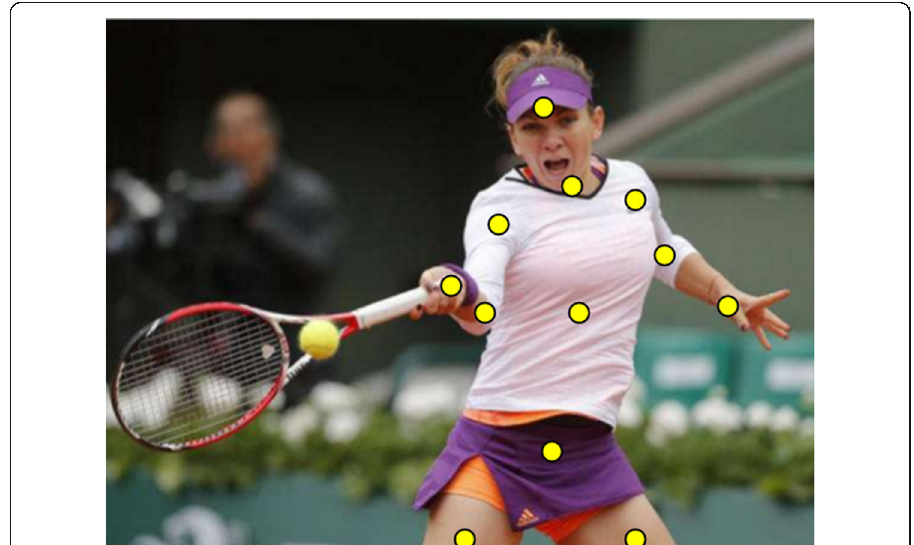
Fig. 5 Athlete joint point